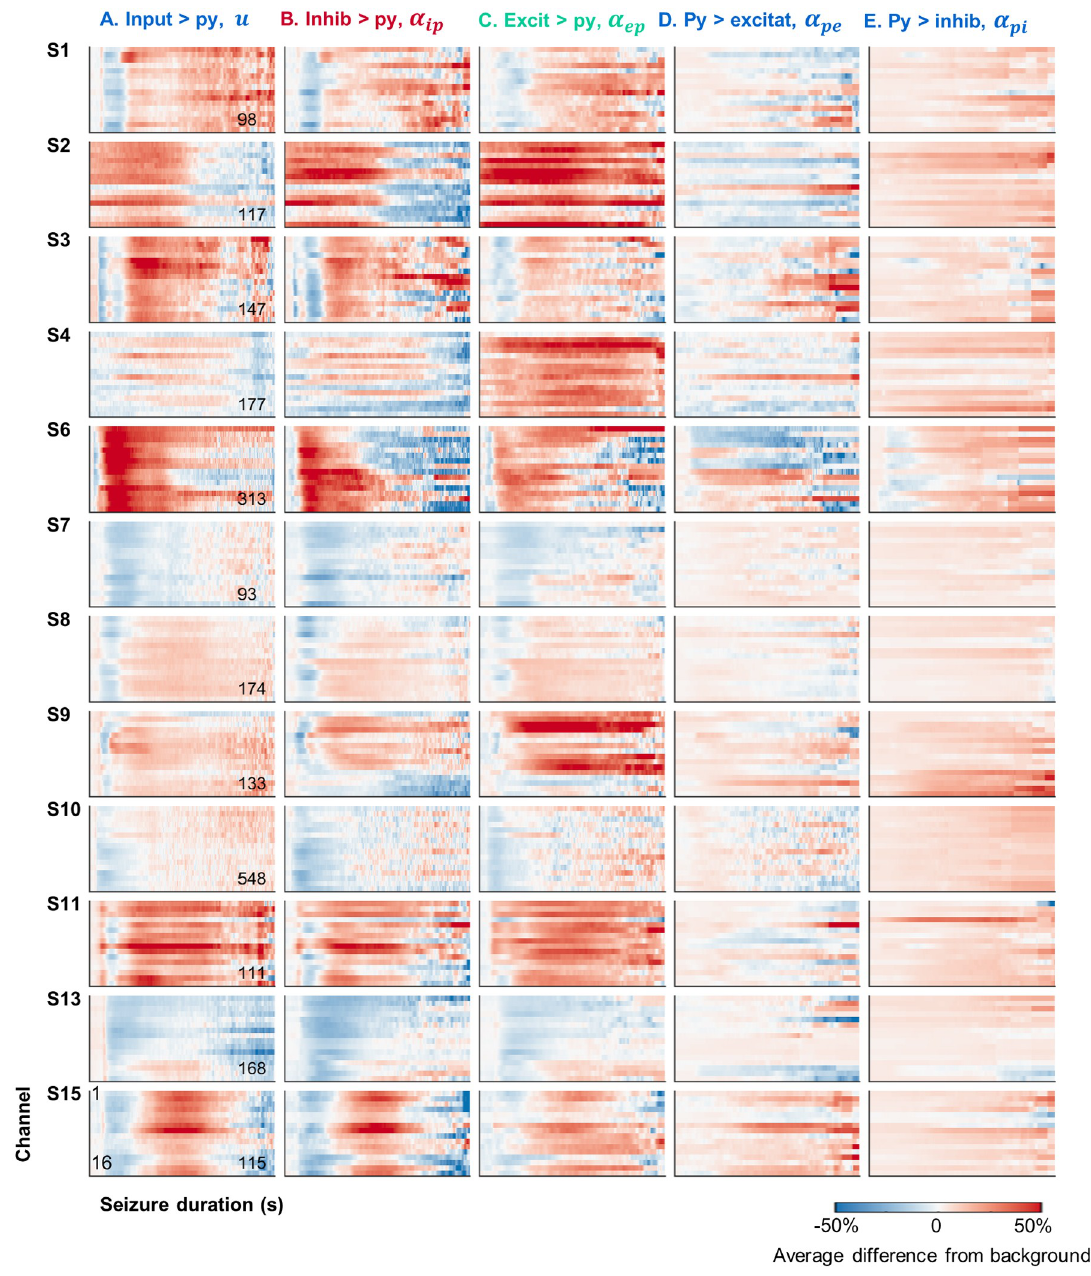
Fig 5. Inter-channel changes in parameter trajectories. Each subpanel represents the mean connectivity strength (averaged across seizures) for all channels (y-axis) for each patient. Parameters are expressed as a percentage change from their pre-ictal background values (where zero reflects no change from the pre-ictal period). The pre-ictal period was defined from two minutes to one minute before seizure onset. Significant changes are shown in the Supplementary Material (S6 Fig). Columns from A-E show the connectivity parameters: A) external input to pyramidal neurons, B) inhibitory to pyramidal connectivity, C) excitatory to pyramidal connectivity, D) pyramidal to excitatory connectiviy, E) pyramidal to inhibitory connectiviy.